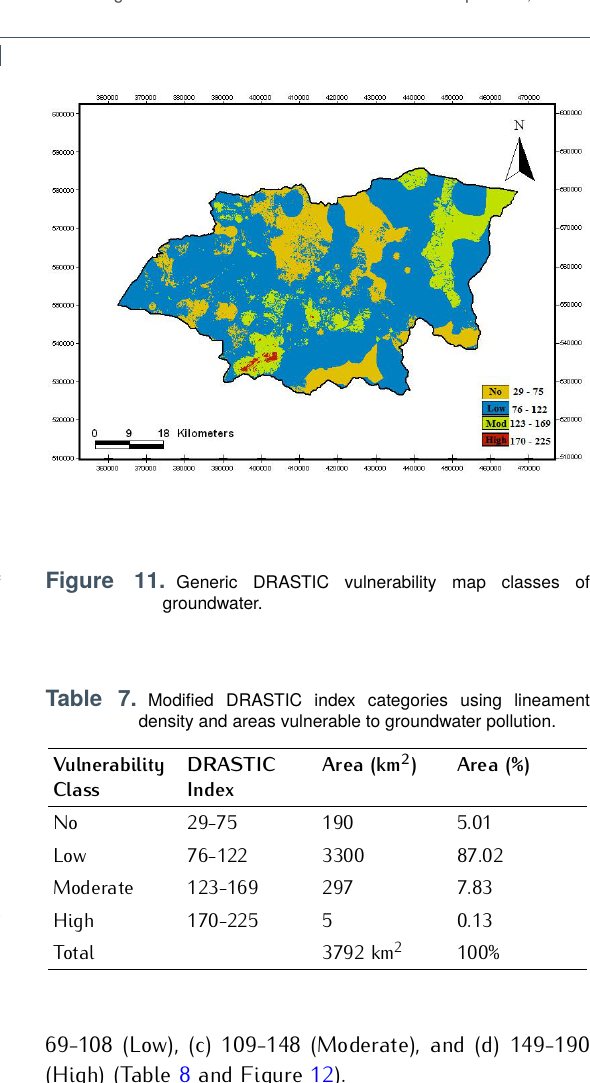
(High) (Table 8 and Figure 12).